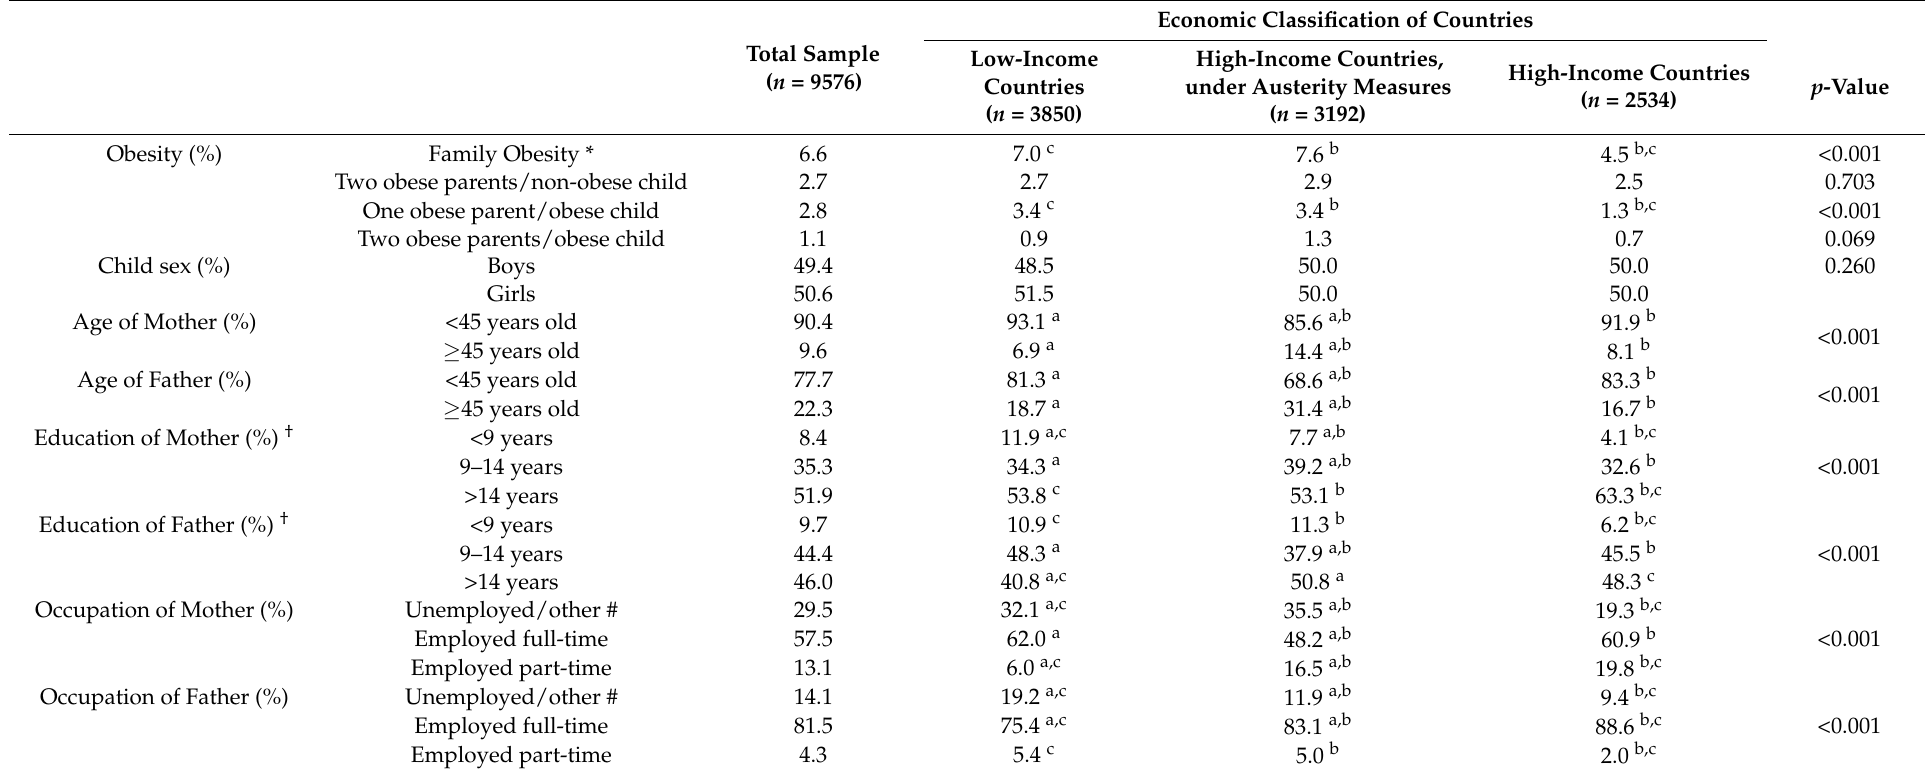
Table 1. Socio-demographic characteristics of families in the total sample and by economic classification of